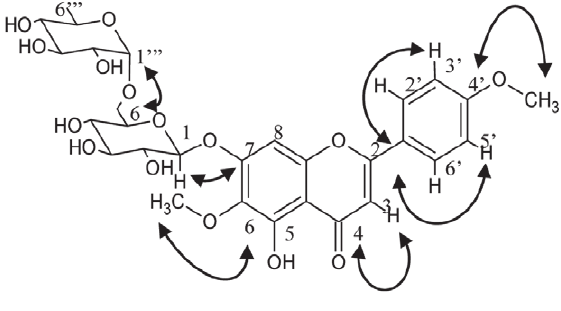
Fig. 2 - Main 1 h → 13 C correlations inferred from HMBC pectolinarin